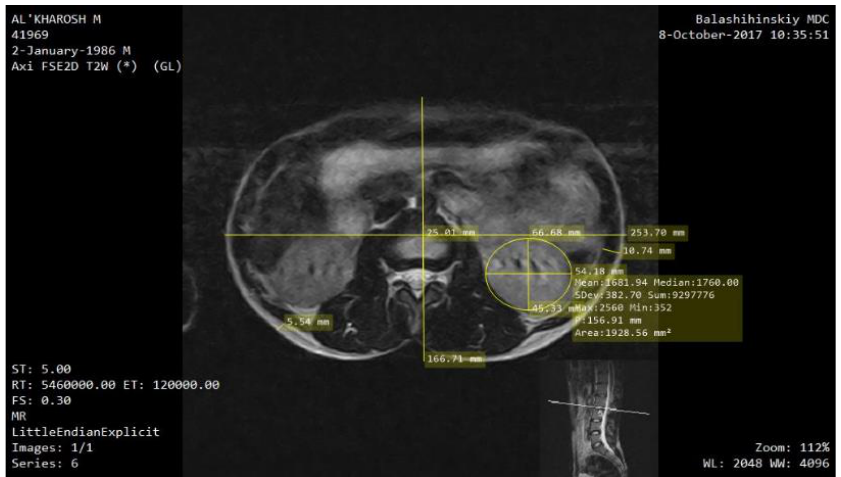
Figure 2. Assessment of the kidney location, its geometric dimensions and the thickness of the perirenal layers according to the MRI image.